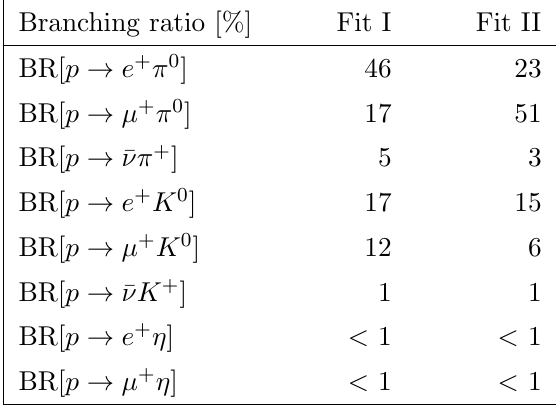
Table 2 . Proton decay branching fractions for two di(cid:11)erent (cid:12)ts to the (cid:13)avour spectrum. with (cid:13)avour (cid:11) ( i ) and a quark with (cid:13)avour i ( (cid:11) ), are given